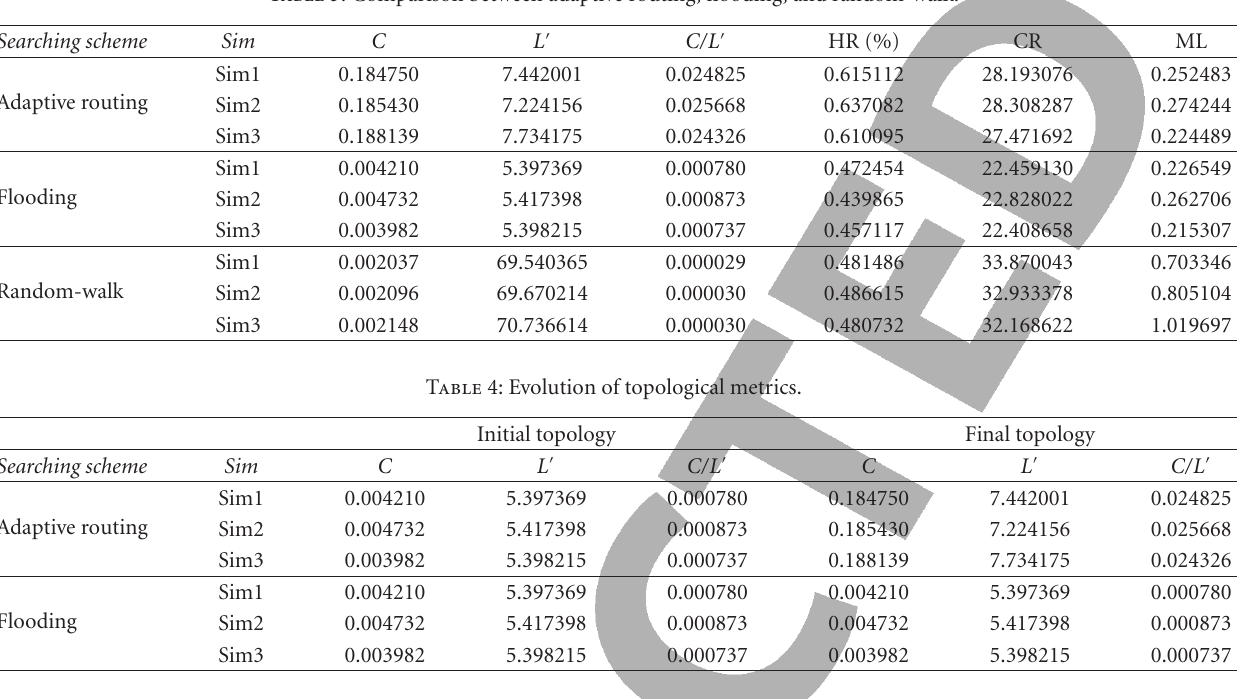
Table 3: Comparison between adaptive routing, flooding, and random-walk.